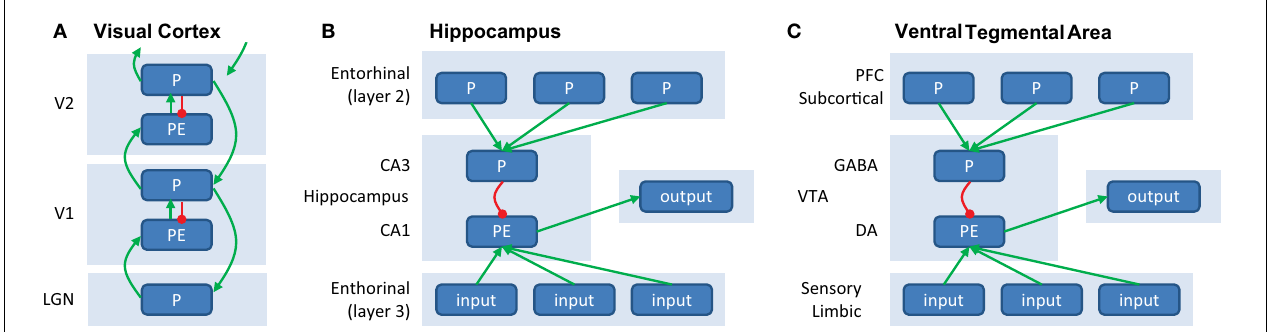
hippocampus. Predictions, based on stored memories drive CA3 via layer 2 of the entorinal cortex. CA3 provides an inhibitory signal to CA1. At the same time, sensory inputs from layer 3 of the entorhinal cortex provide excitatory input to CA1, which is thought to serve as a “comparator” between predictions and input.The resulting mismatch is sent as output to (a.o.)VTA. (C) Generation of PEs withinVTA.VTA GABAergic neurons exert an inhibitory influence that counteracts the driving excitatory input from primary rewards when the reward is expected, see also Figure 1F